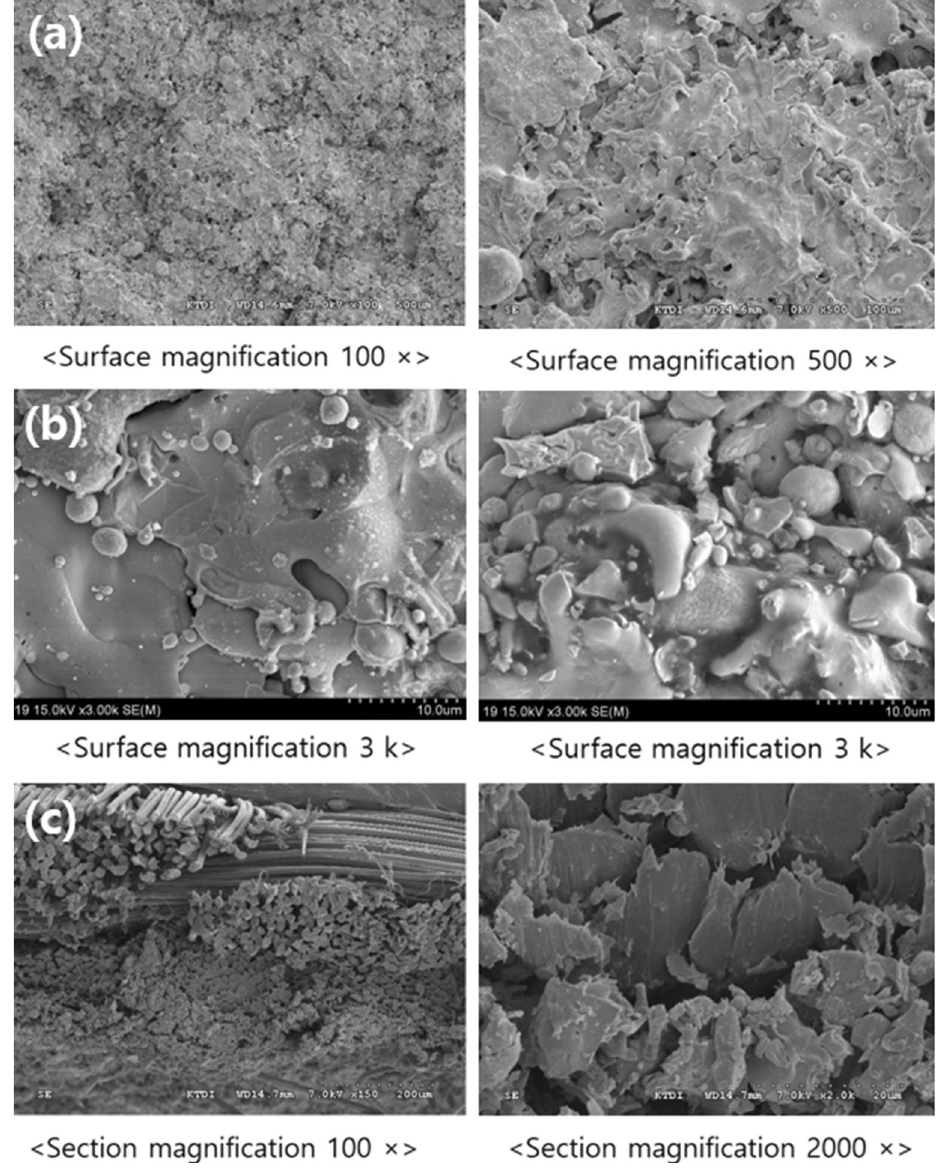
Figure 10. Tungsten-coated shielding fabric. (a) An enlarged image of the surface of the fabric, and (b) the distribution of tungsten particles in the enlarged surface image, (c) the enlarged cross-sectional image of the